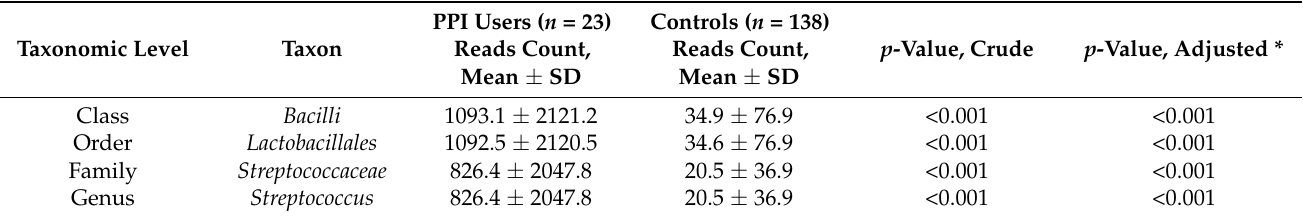
Table 2. Distribution of the Bacilli class and its major subclass between and proton pump inhibitor users and controls.